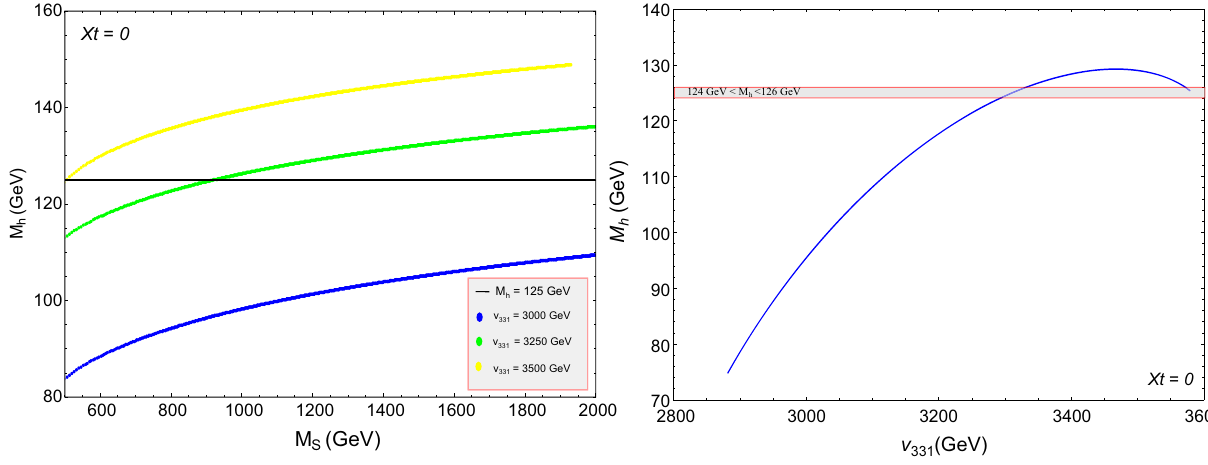
Fig. 4 Left: M h versus M s for X t = 0 for three different values of v 331 . Right: M h versus v 331 for X t =